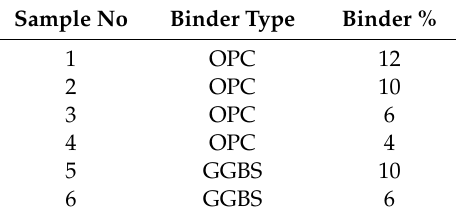
Table 3. Monolith tank test